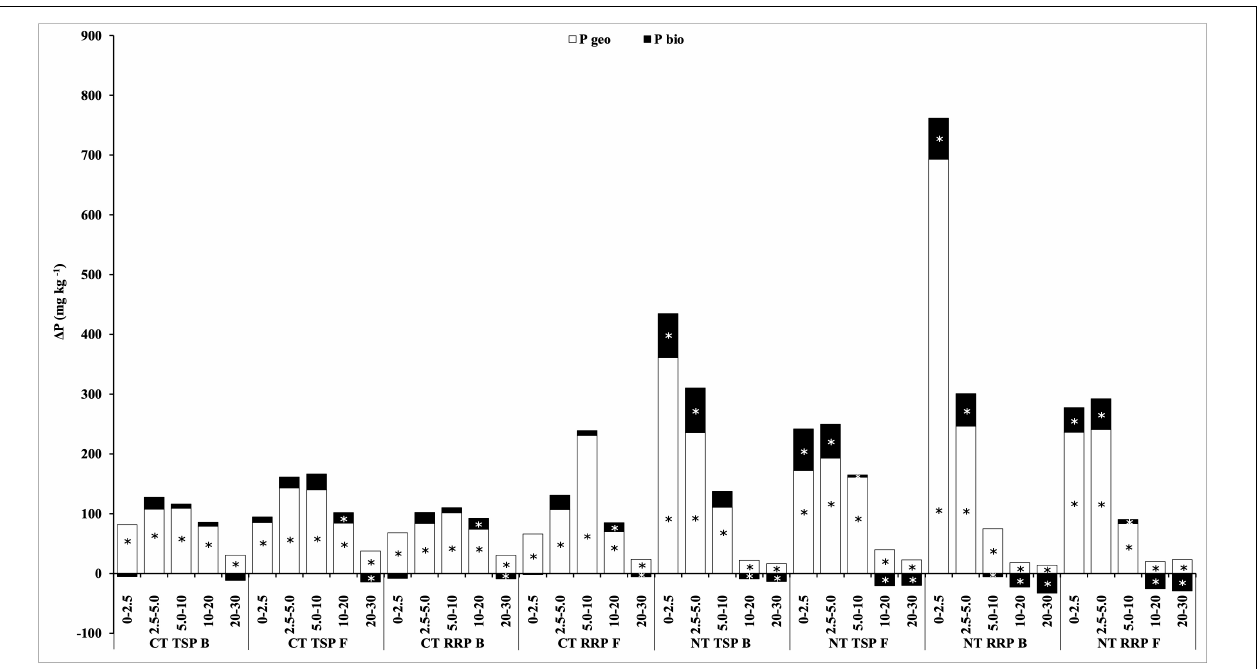
FIGURE 3 | Variation in geochemical and biological P in relation to natural Cerrado in five layers of a very clayey Oxisol after 17 years of cultivation under distinct soil management systems and phosphate fertilizer sources and application methods. CT, conventional tillage; NT, no-tillage; TSP, triple superphosphate; RRP, reactive rock phosphate; B, broadcast; F, furrow. *Significant according to the Student’s t -test at P < 0.05.